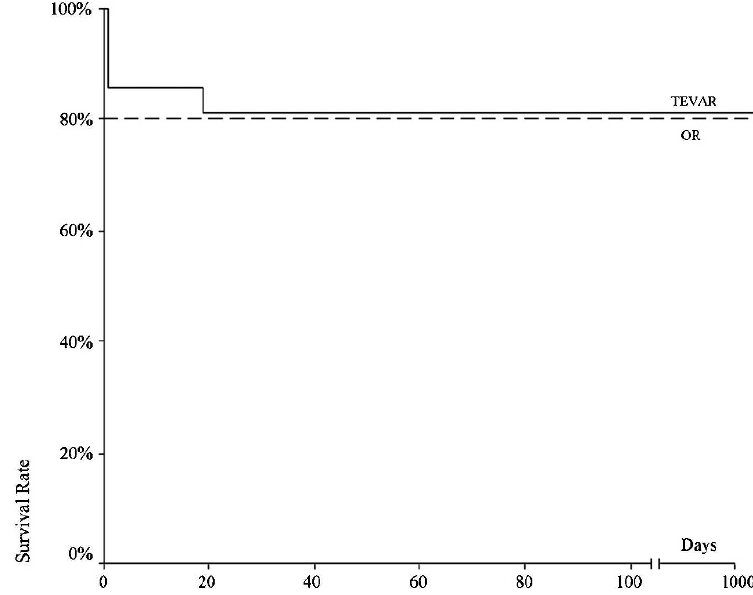
Figure 3 - Survival (Kapplan-Meier) of patients submitted to TEVAR or OR to treat blunt aortic